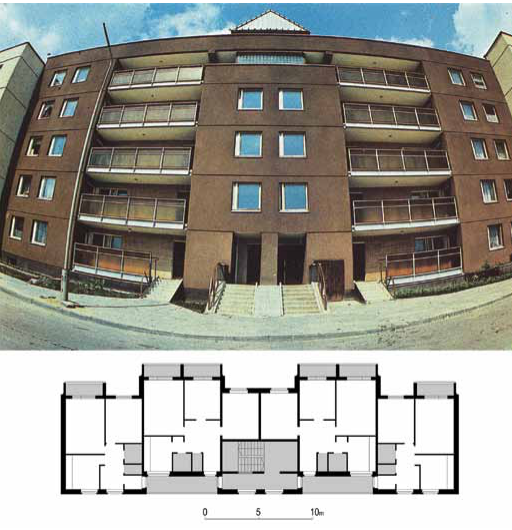
14 pav. Ekraninis namas justiniškėse (archit. Danas ruseckas; statytas nuo 1983 m.) Fig. 14. Barrier block in justiniškės (archit. Danas ruseckas, constr. st. in